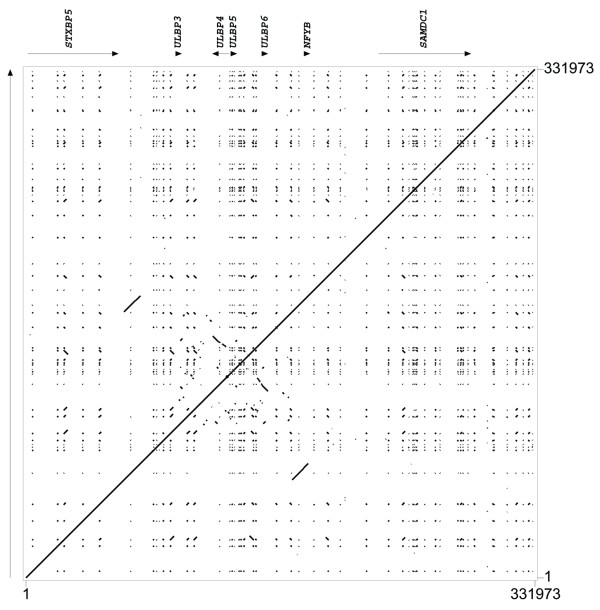
Internal sequence identity plot of the minor ULBP cluster. Sequence numbers displayed on the X- and Y-axes indicate alignment orientation, originating in the lower left corner. The central diagonal line represents identity; other lines indicate regions of internal sequence identity. Genes are annotated above the figure with arrows indicating orientation. Nucleotide sequences used to construct the minor ULBP cluster are listed in Table 1.